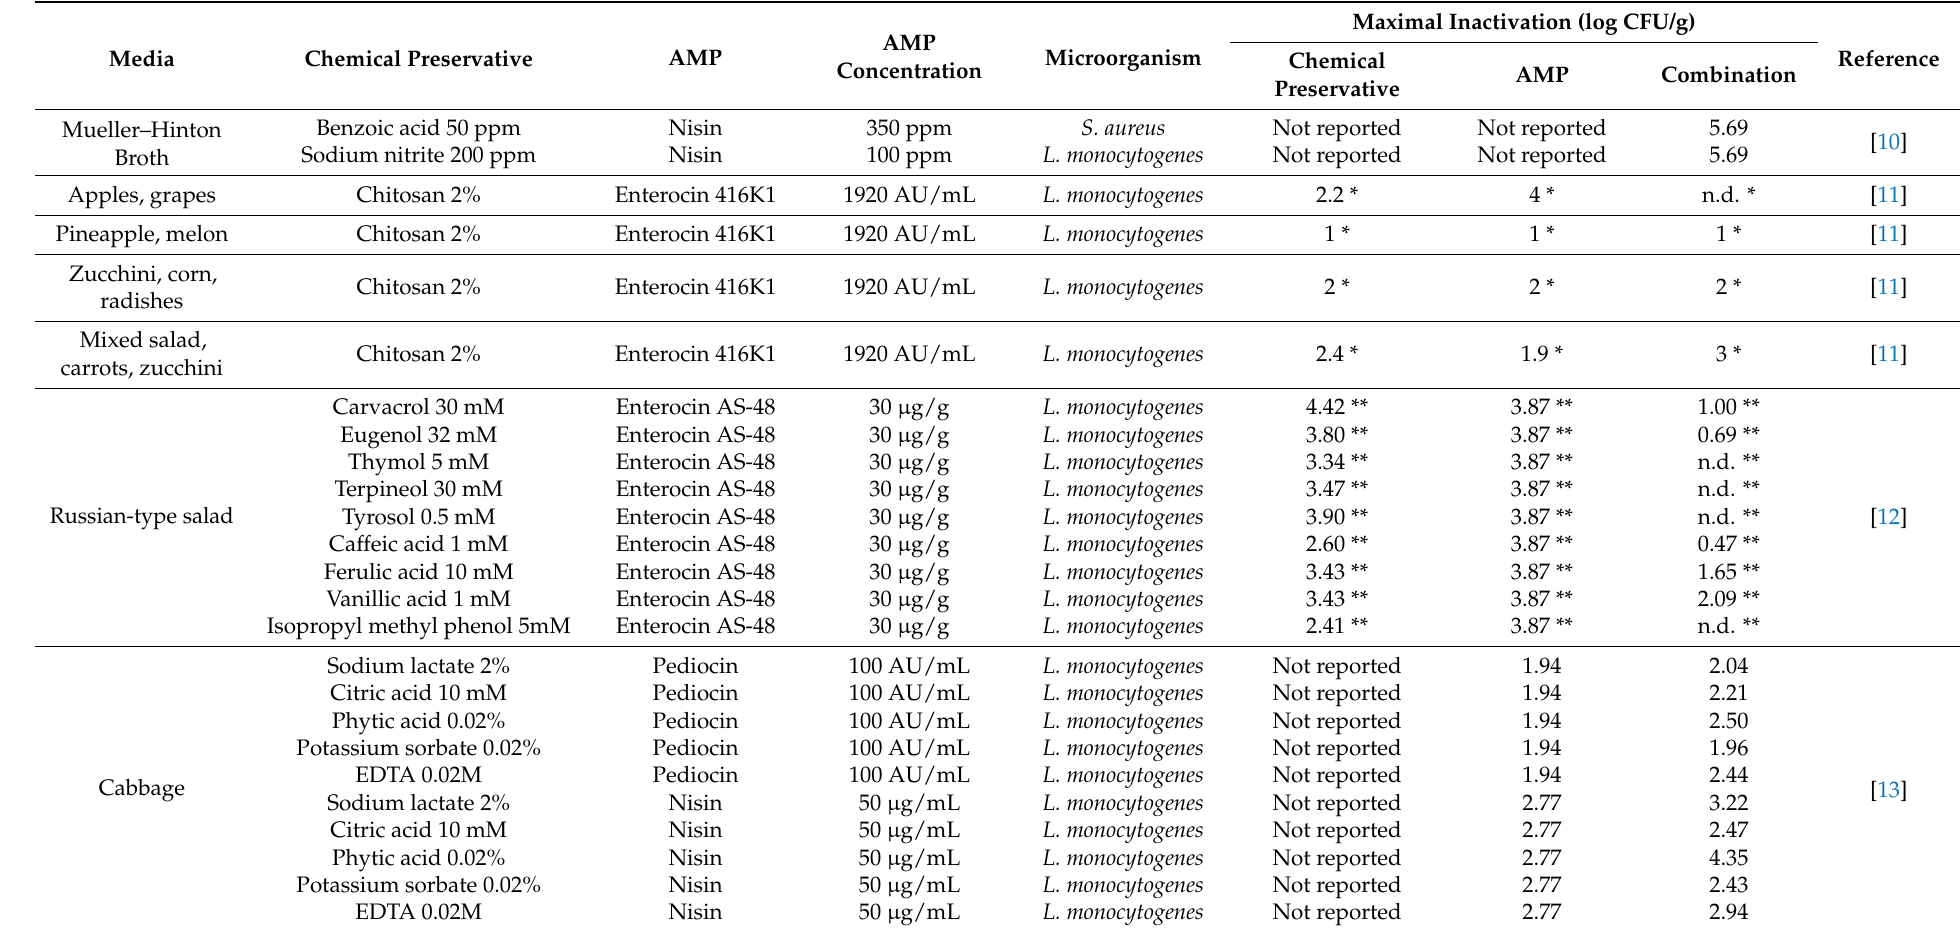
Table 3. Effect of chemical preservatives and antimicrobial peptides (AMPs) on microbial inactivation in food